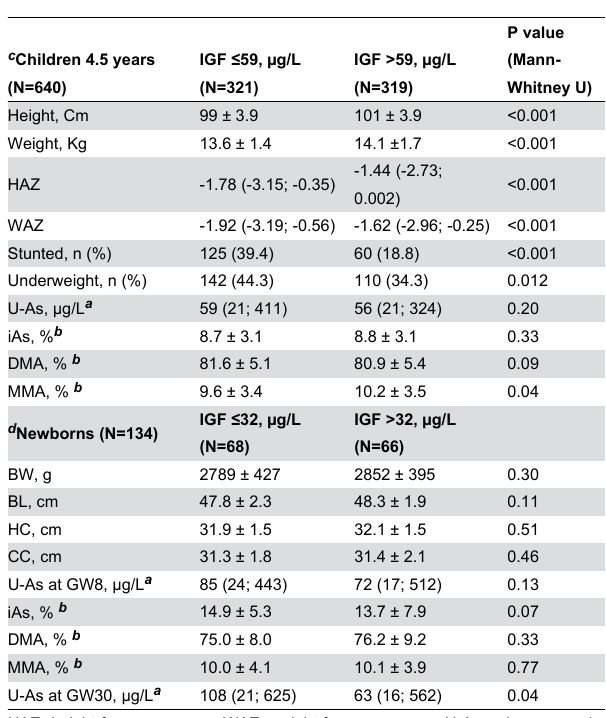
108 (21; 625) 63 (16; 562) 0.04 HAZ, height-for-age z-score; WAZ, weight-for-age z-score; U-As; urinary arsenic; BW, birth weight; BL, birth length; HC, head circumference; CC, chest circumference. Data given as mean ± standard deviation, median (5; 95 percentiles), or n (%). a Adjusted to average specific gravity of 1.012 g/mL. b Percent of total metabolite concentration in urine. c Children at 4.5 years of age in relation to children blood IGF-1. d Newborn characteristic in relation to cord blood IGF-1. doi: